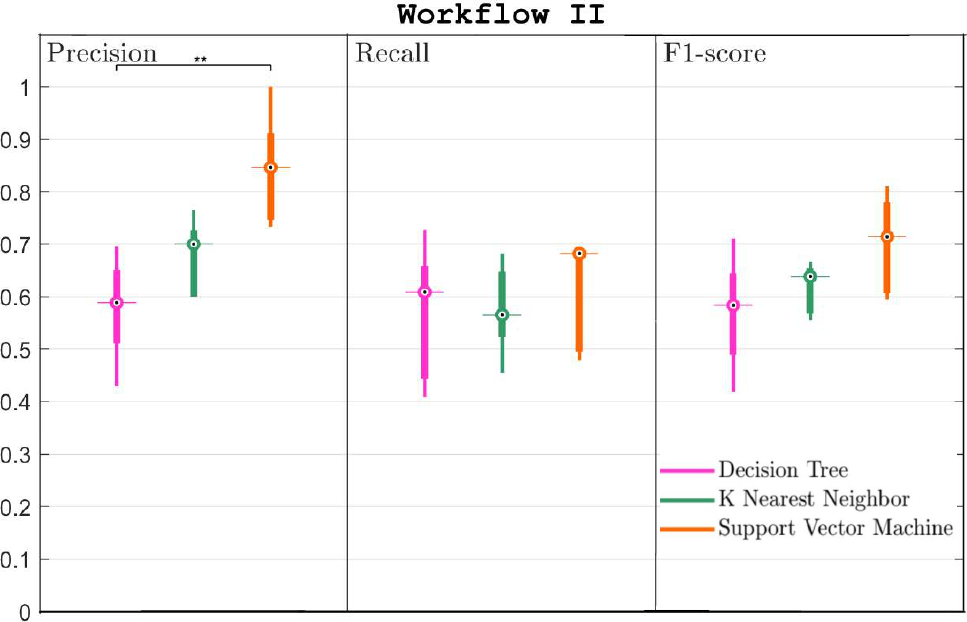
Figure 5. Workflow II. Boxplot of precision, recall, and f1 score distributions on test sets for weld defective class among three classifiers performing on ’feature reduction’ setup with ** representing statistically significant comparisons with p ≤